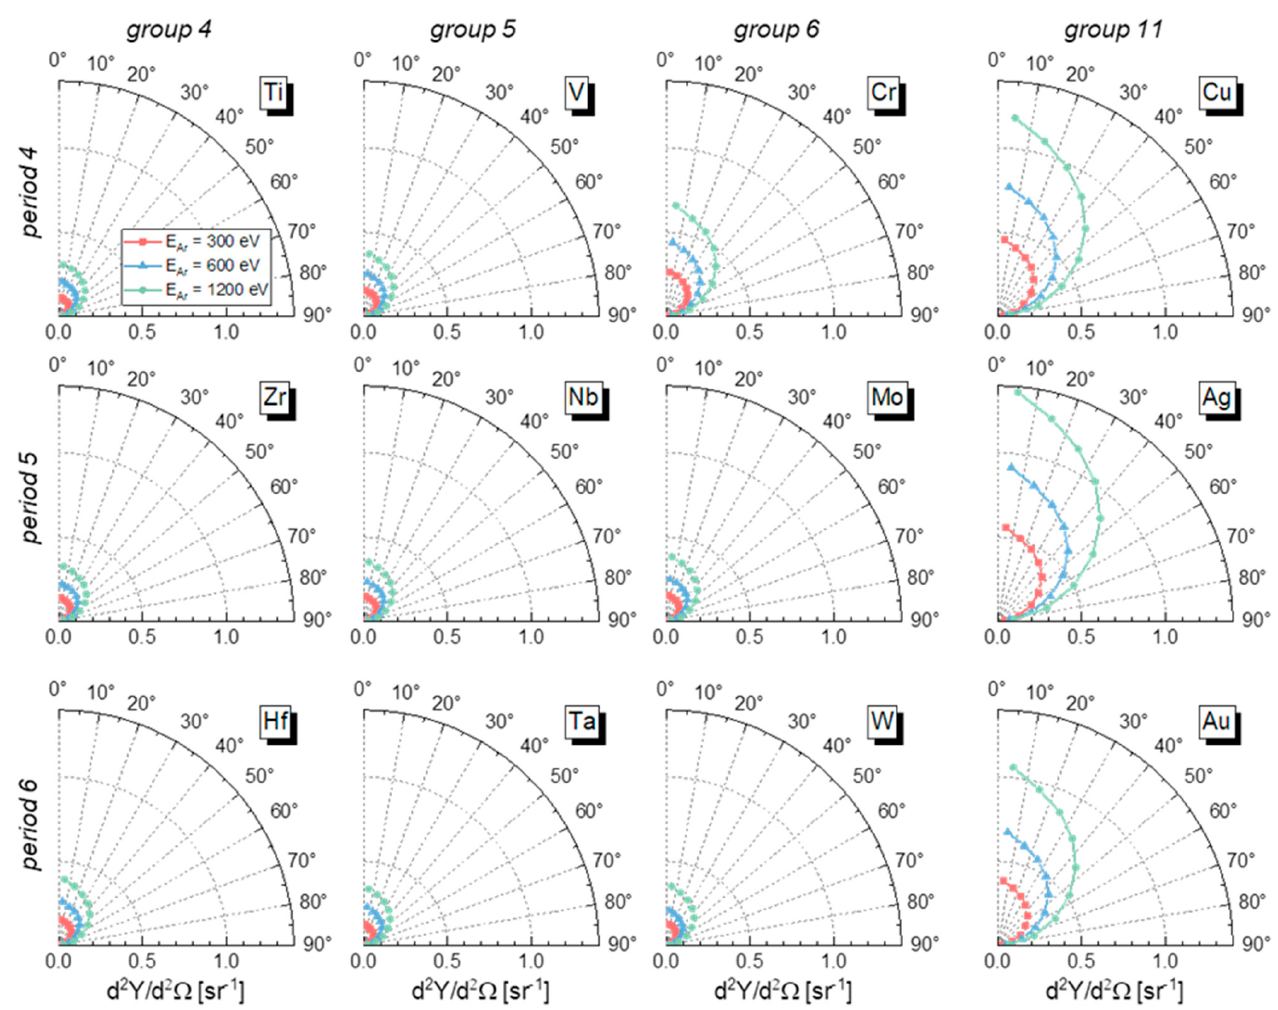
Figure 5. Angular distribution of sputtered metallic elements (groups 4–6 and 11) with 300 eV (red), 600 eV (blue), and 1200 eV (green) energy argon ions at perpendicular incidences. The graphs show the number of sputtered atoms in a particular polar angle interval.